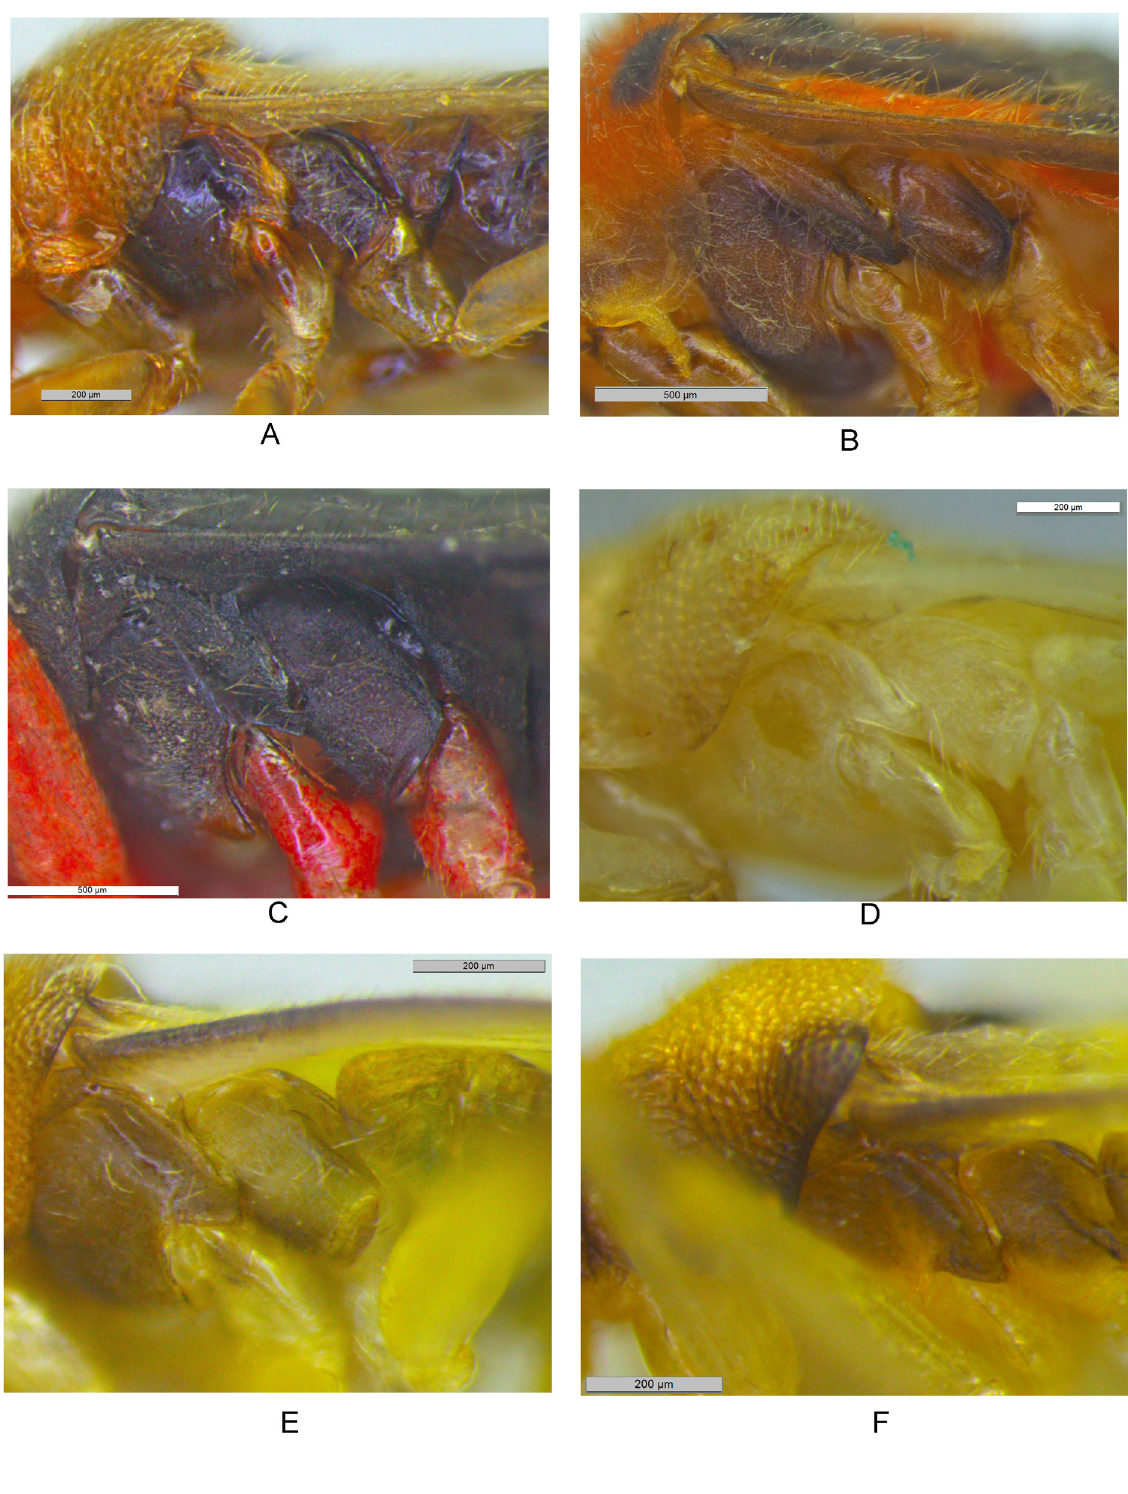
Fig. 25. Scent gland evaporatory area. A . Harpedona vittlaensis sp. nov., UASB. B .